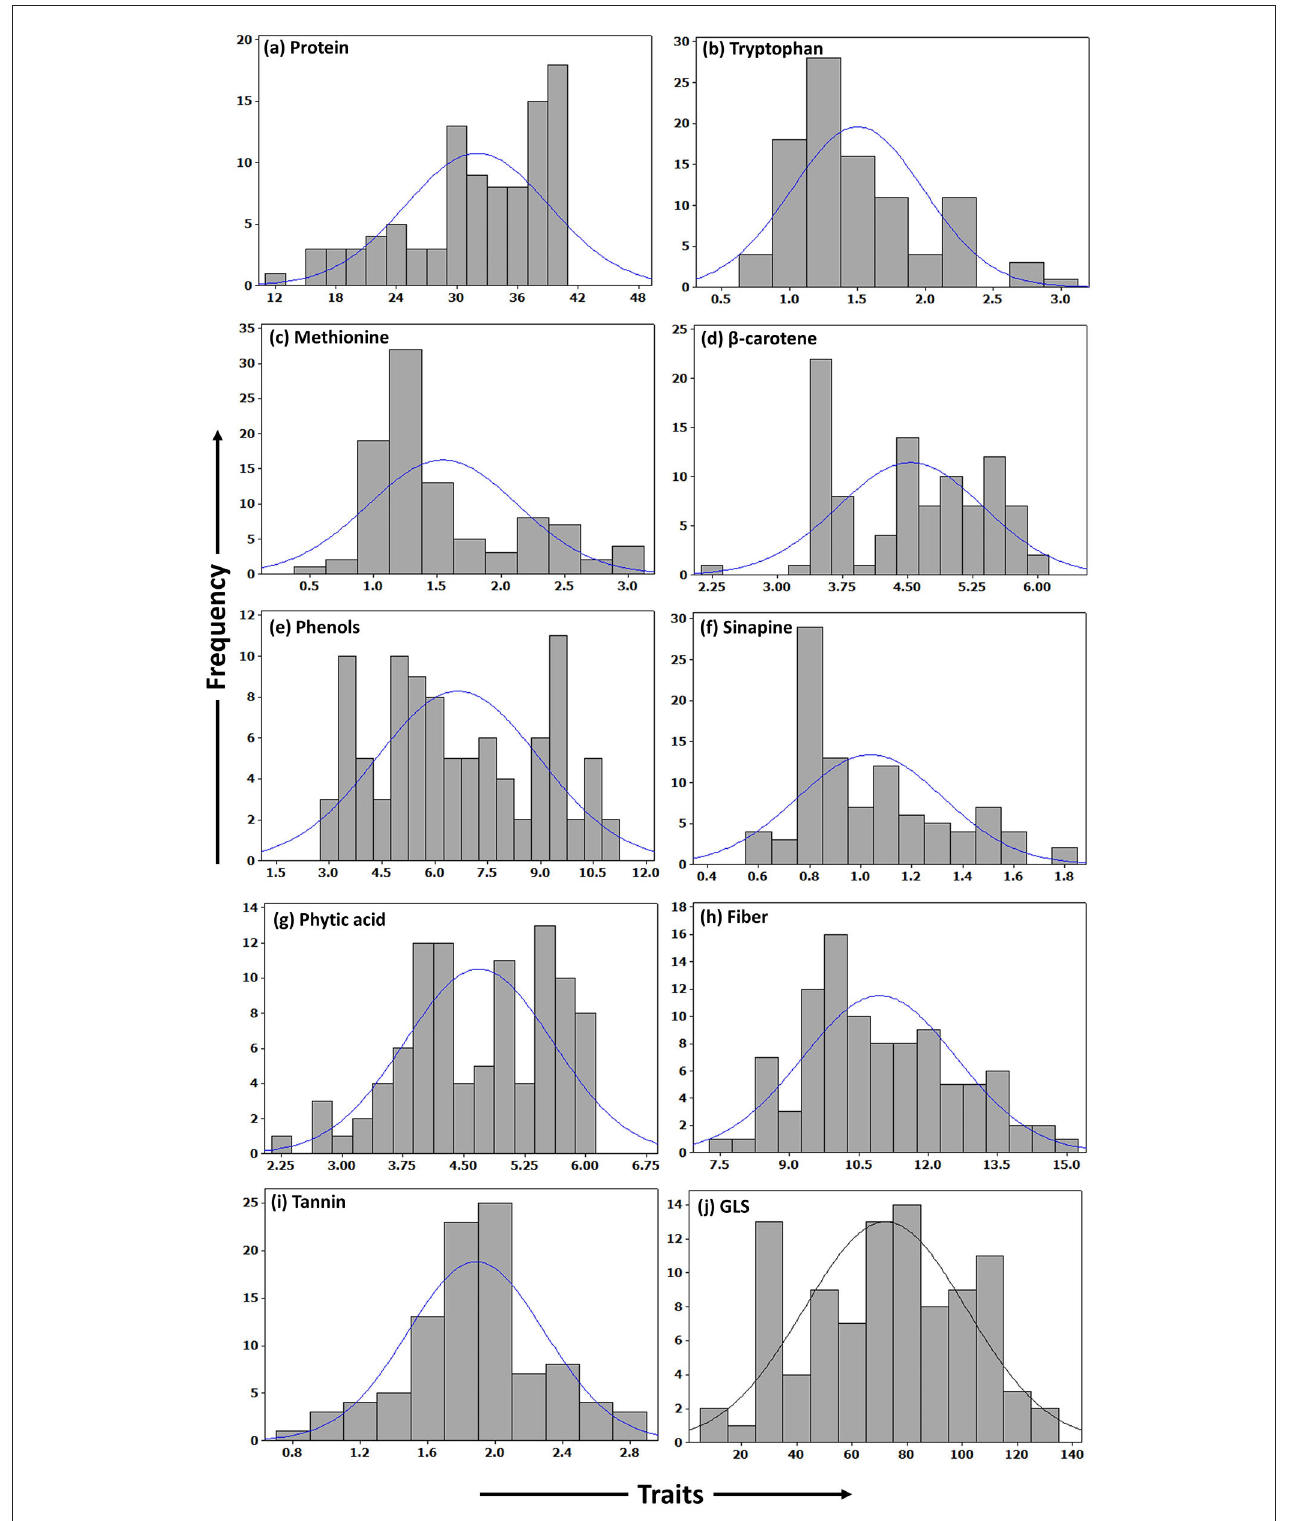
FIGURE 1 | Frequency histograms showing distribution of quality traits in seed meal of B. napus accessions. (a) Protein. (b) Tryptophan. (c) Methionine. (d) β -carotene. (e) Phenols. (f) Sinapine. (g) Phytic acid. (h) Fiber. (i) Tannin. (j) GLS.